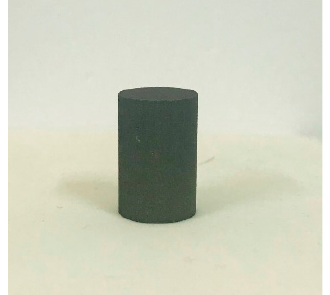
Figure 1. Testing Sample.